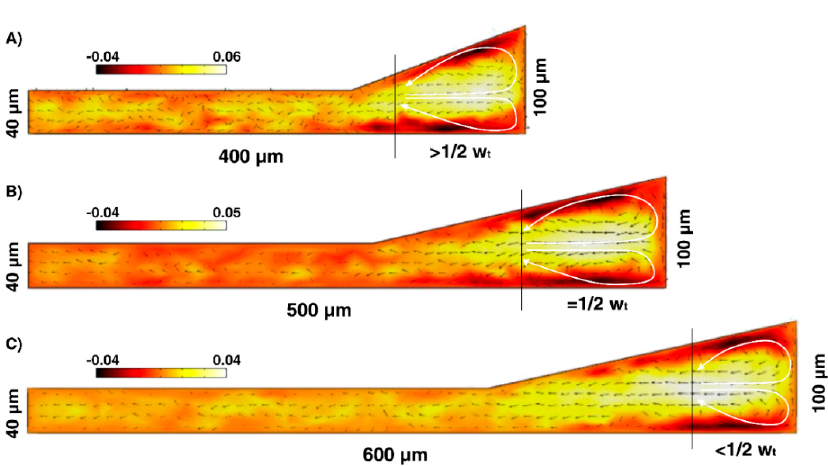
Figure 2. Simulation results indicating secondary flow in complex cross-sectional channels. The